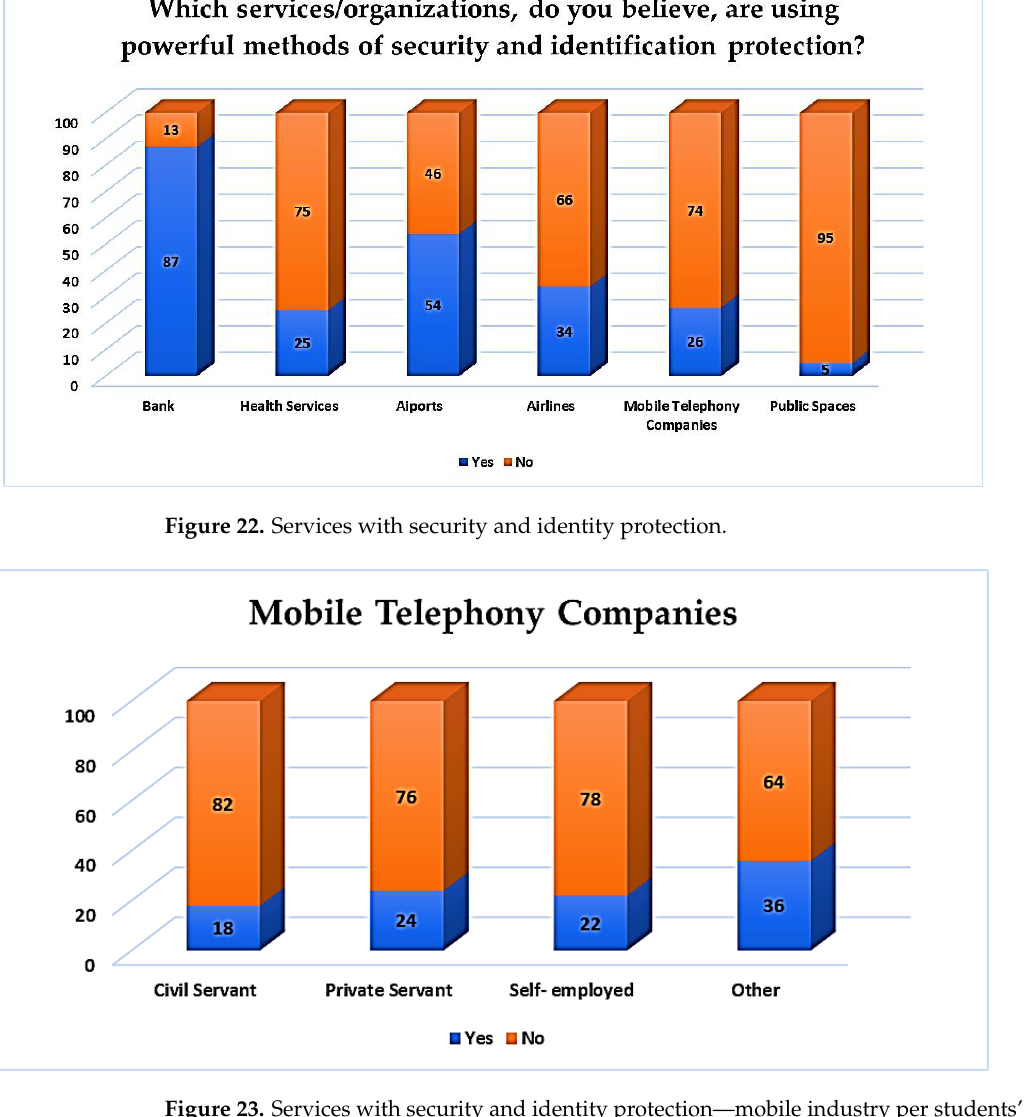
Figure 23. Services with security and identity protection—mobile industry per students’ professional profile .